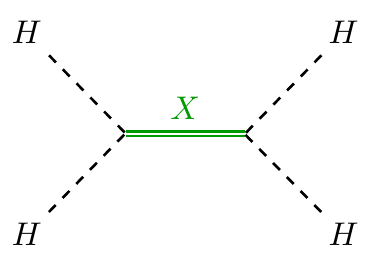
Figure 7 . Tree-level completion of a ( DH ) 4 operator, where X is a heavy (cid:12)eld transforming under a speci(cid:12)c representation of SU(2) L . In the text, we consider a number of examples for X and show in all cases that, when it is integrated out, the coe(cid:14)cients of the ( DH ) 4 operators generated always satisfy our